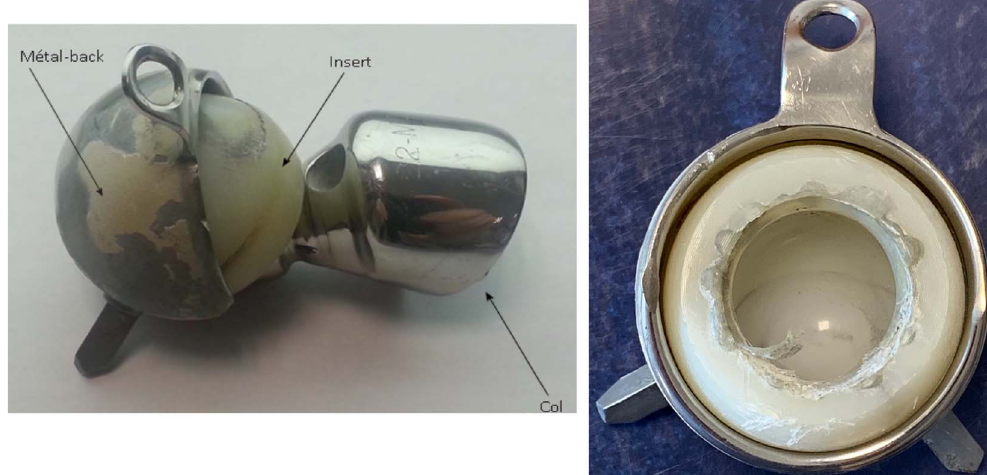
Figure 2. Photograph of the explant analysed.